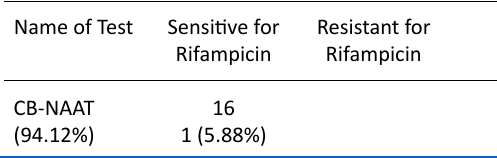
table 9. Drugs sensitivity with CB-NAAT in